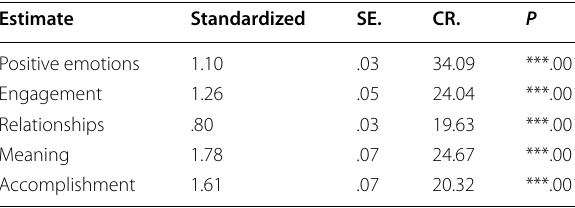
(2) engagement, (3) relationships, (4) meaning, and (5) accomplishment. The results demonstrated good indices values with a good model of fit (CFI .95, GFI .96, NFI = = .90, RFI .89, IFI .91, and RMSEA = = = =